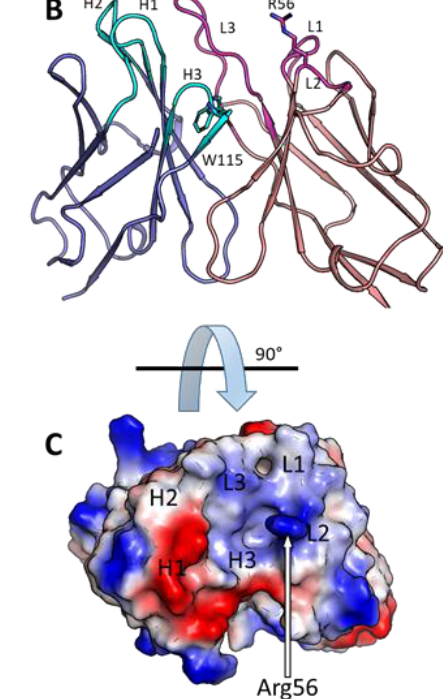
Figure 3. Structure prediction of antibodies. ( A ) Model structures of the three isolated antibodies (scFvs) indicating that all three antibodies are predicted to have very similar structures (red: SNAP1, blue: SNAP2, white: SNAP3). ( B ) Model structure of SNAP1 scFv with light chains colored in pink and heavy chains colored in blue. Rare Trp115 in CDR H3 (cyan sticks) and solvent-exposed Arg56 in CDR L2 (magenta sticks) are shown. ( C ) Electrostatic model of SNAP1 scFv shown indicating that the short CDR H3 creates a groove in the predicted structure.